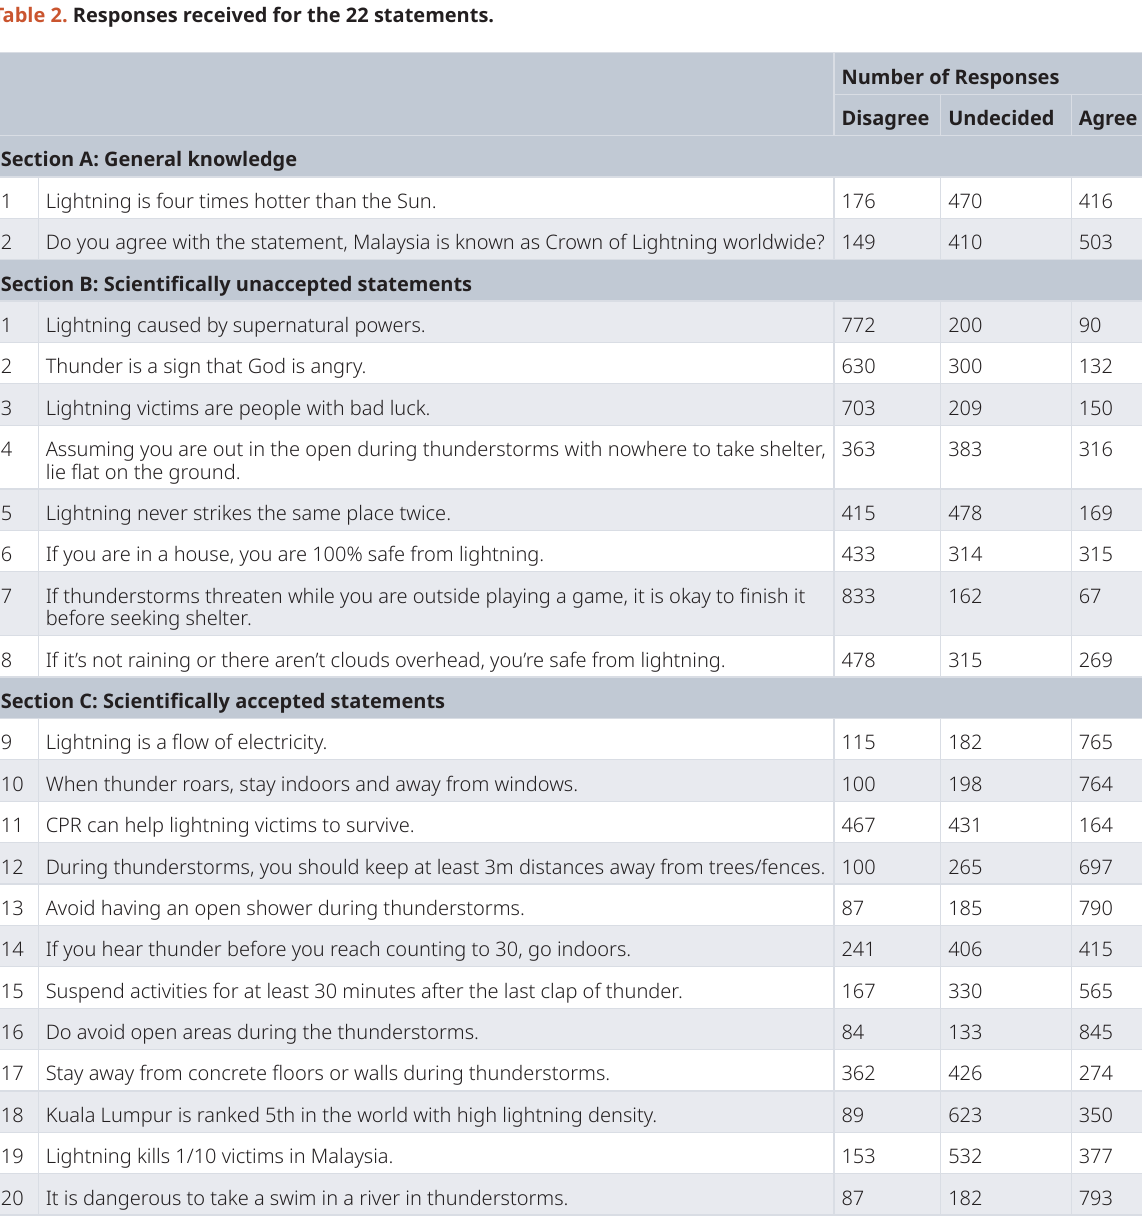
Table 2. Responses received for the 22